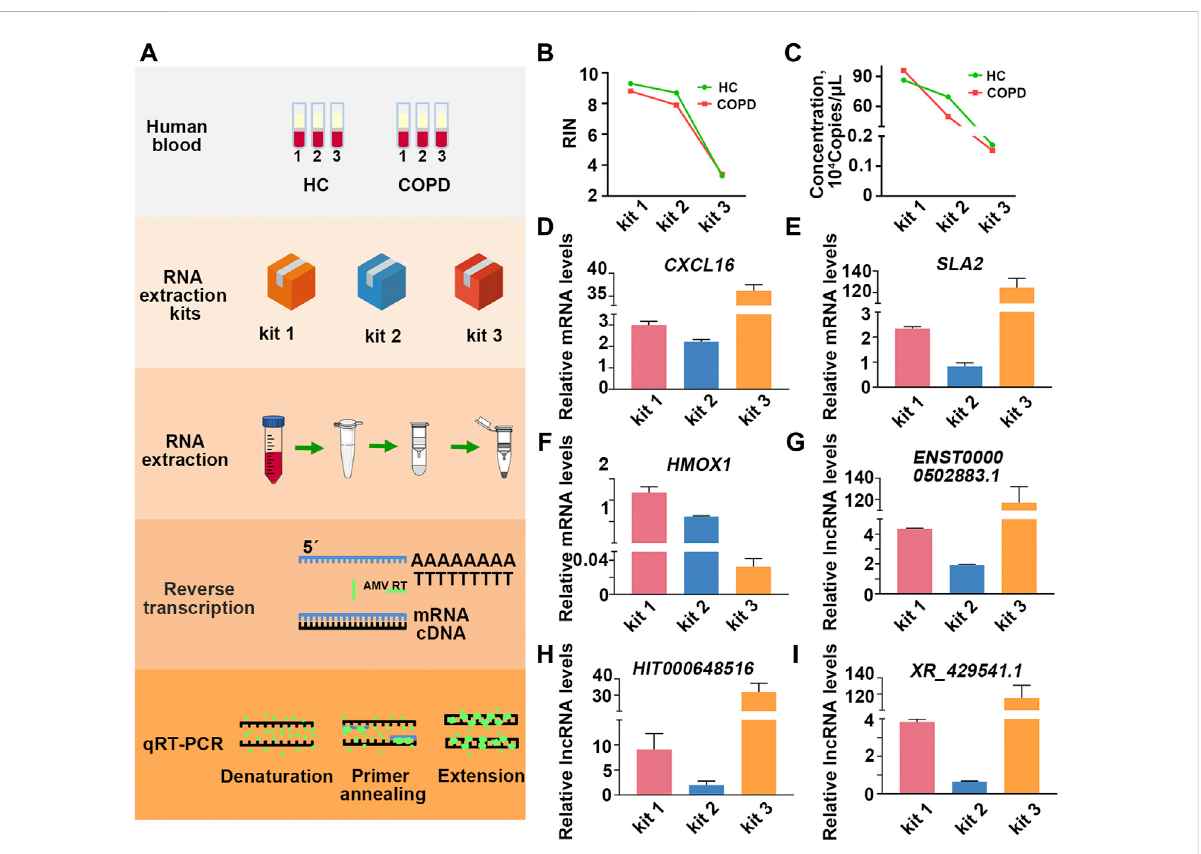
Comprised RNA leads to skewed transcriptional readouts in COPD patient. (A) Schematic illustration of the experimental schedule. (B) The RIN values in each group. (C) The quanti fi cation of β -actin copies in each group. (D – F) The relative transcriptional readouts of the informative mRNAs in COPD patient in each group. (G – I) The relative informative lncRNAs readouts in COPD patient in each